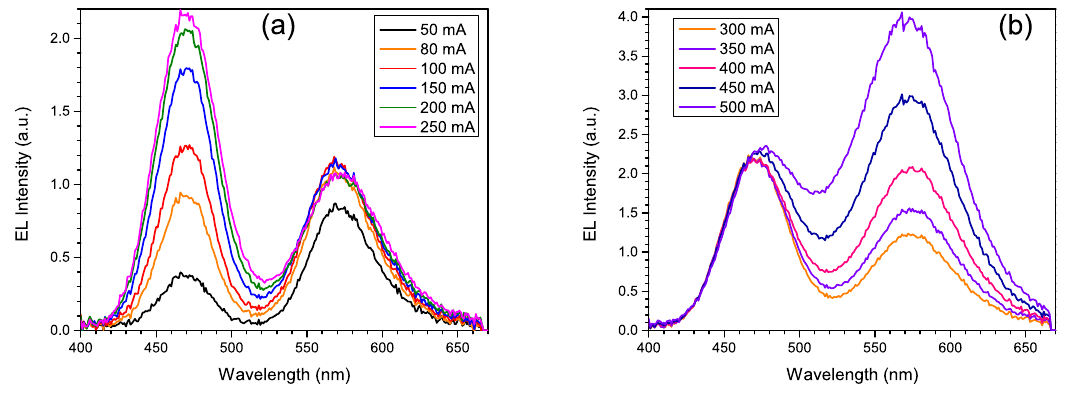
Figure 2. Electroluminescence (EL) spectra of monolithic white LED pumped with the continuous wave (CW) current of: ( a ) 50–250 mA; and ( b ) 300–500